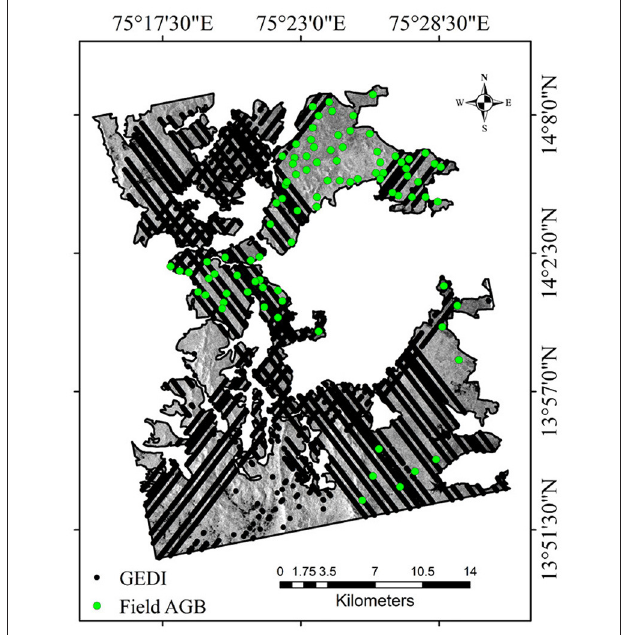
FIGURE 1 | Shivamogga forest range image acquired by ALOS-2/PALSAR-2 (HV polarization), Karnataka. Green color circles represent field measured above-ground biomass plot locations and black dots shows the spatial distribution of GEDI footprints (showing transects of footprints after filtering).